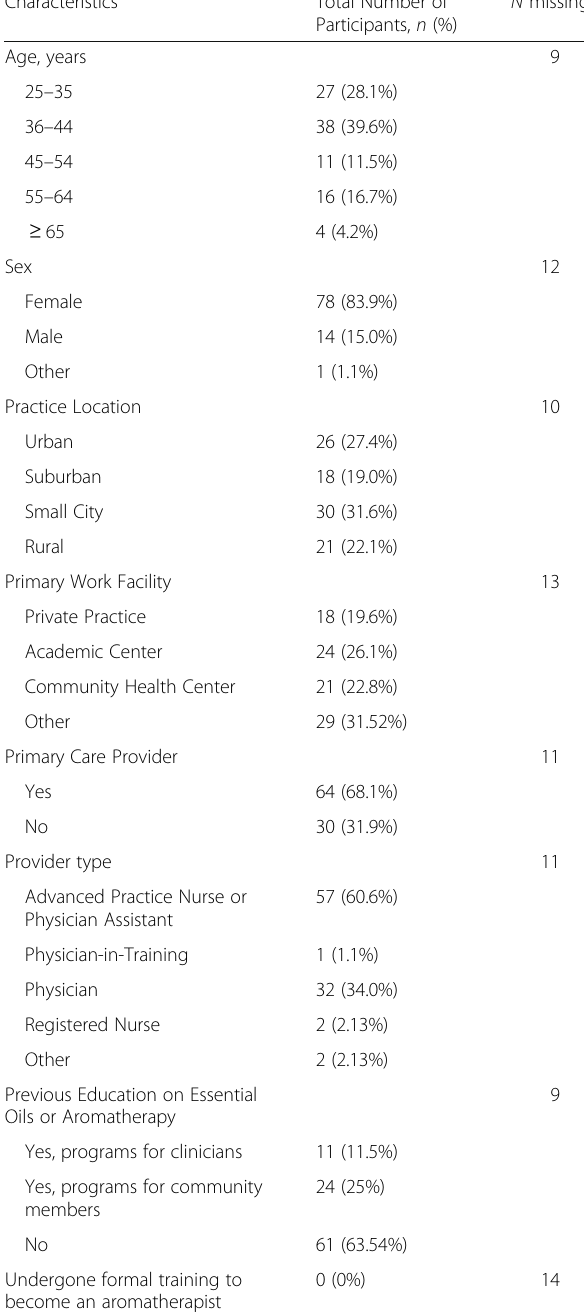
Table 1 Participant characteristics, N =